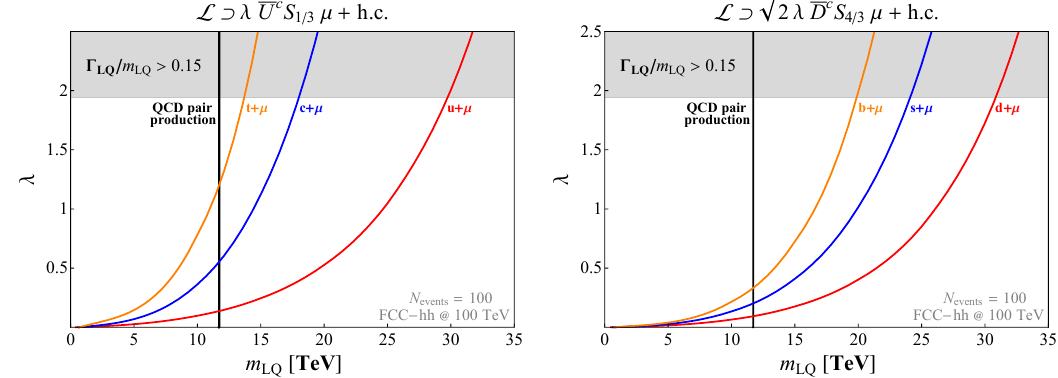
Figure 8 . Contours in the ( m LQ , λ ) plane for producing 100 events at the FCC-hh for ± 1 / 3 (left plot) and ± 4 / 3 (right plot) charge components of the S scalar leptoquark model from section 3.4. 3 The solid black line is for the QCD pair production, while the red, blue, and orange are for the resonant leptoquark production, assuming couplings to the first, second, or third generation of quarks, respectively. The grey shaded region shows the regime of a broad